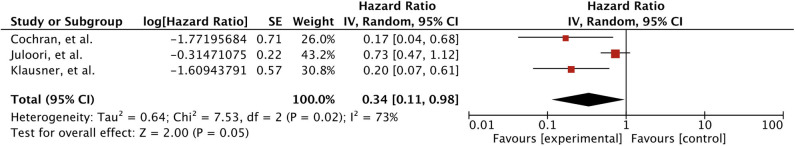
Forest plot of meta-analysis of local control (LC) for treatment comparison (TKIs vs. non-TKIs) in the management of brain metastases from renal cell carcinoma (RCC).